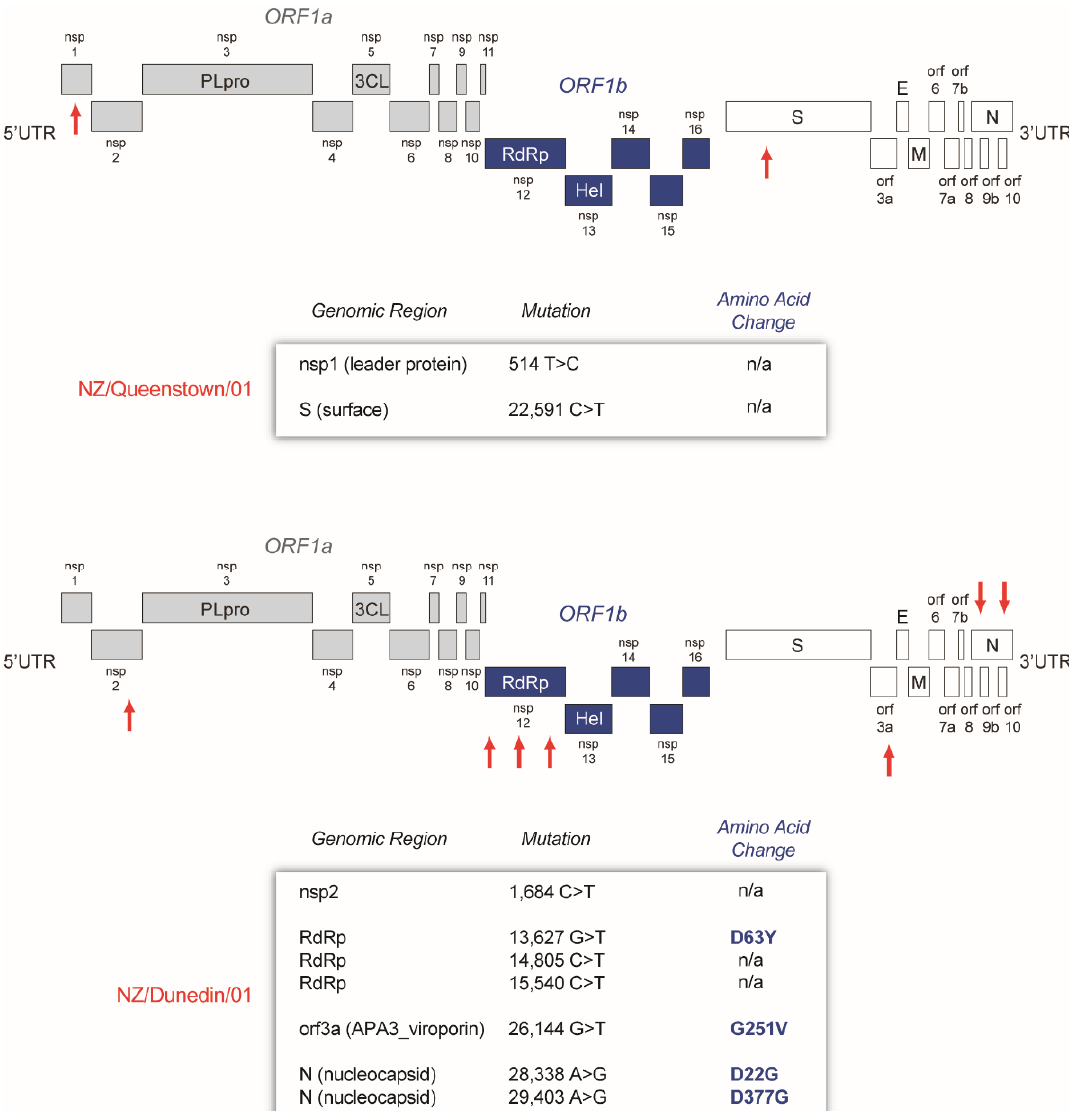
Figure 6. SARS-CoV-2 genome structure depicting the single nucleotide polymorphisms (red arrows) in both NZ/Queenstown/01 and NZ/Dunedin/01 SARS-CoV-2 sequences relative to the Wuhan-Hu-1 (NC_045512) SARS-CoV-2 reference strain. n/a, not applicable (synonymous mutation).